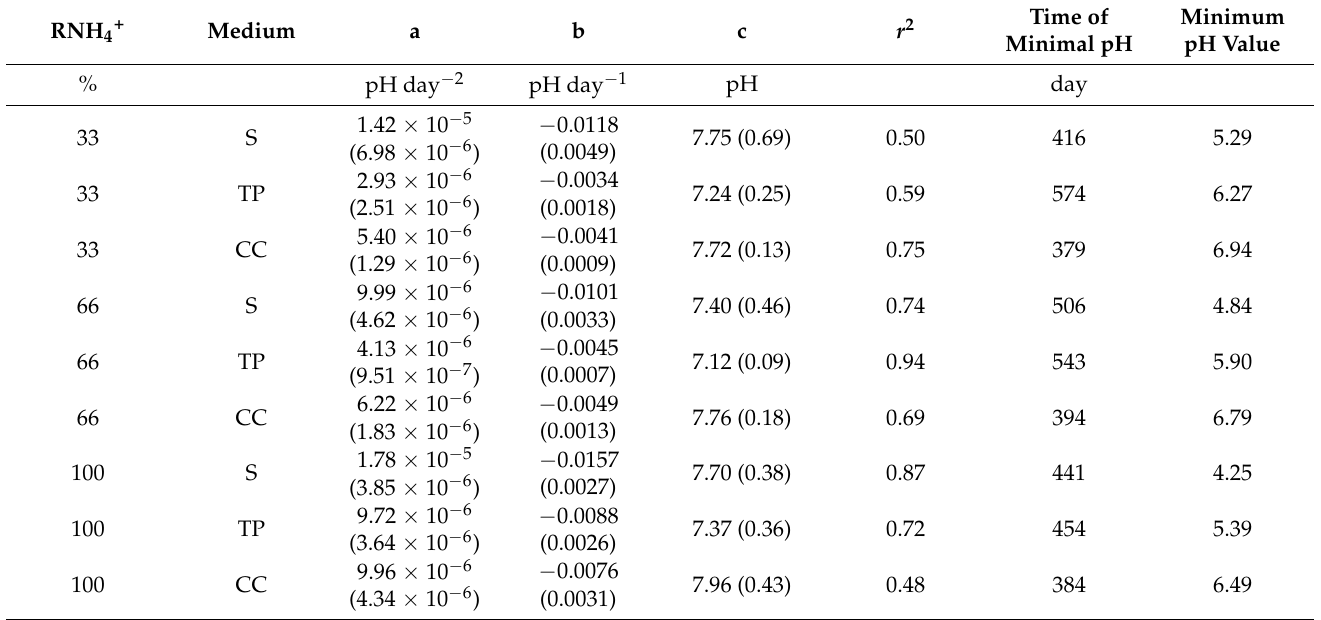
Table 3. The-best fit parameters of Equation (2) for best-fit curves for pH as a function of time (data presented in Figure 2). Values in brackets are approximate standard errors; r 2 = coefficient of determination. a, b and c are constants that were determined by the NLIN procedure (JMP